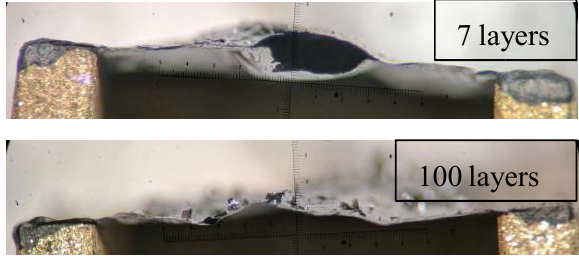
Fig. 5. A view of the border of 7 layers and 100 layers HBC foils after an irradiation of a fluence of 7*10 14 ions/cm² at 1.4 µAe.